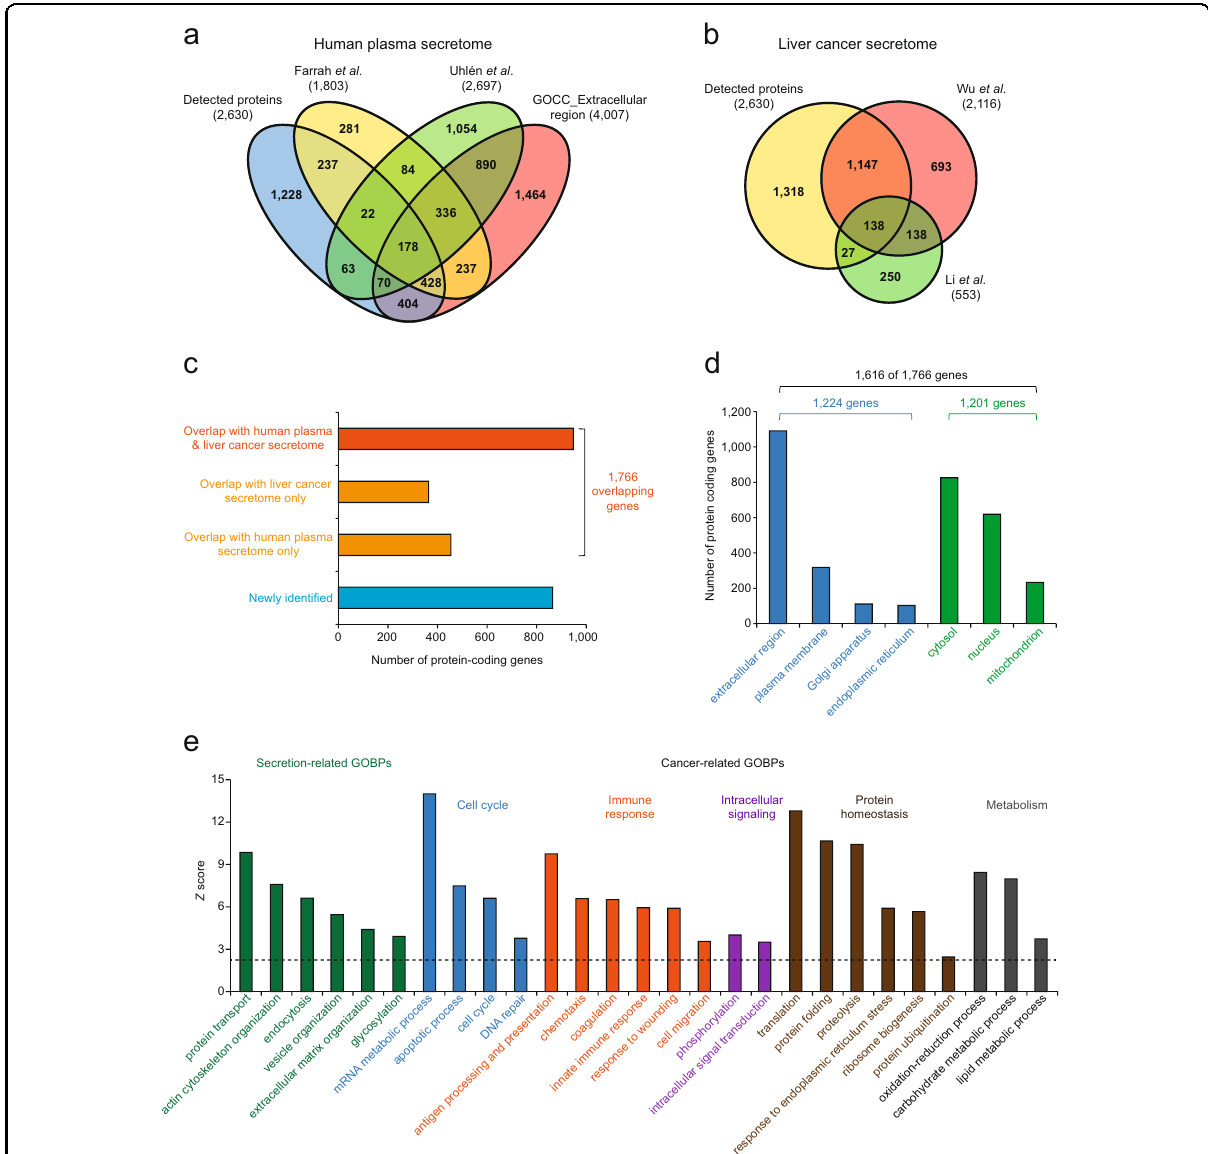
Fig. 2 Comparison of our secretome with the previous secretomes and localization and functional analysis of the secretome. a Comparison of our secretome with human plasma secretomes previously reported and with protein-coding genes known to be localized in the extracellular region based on their GOCCs. b Comparison of our secretome with two previously reported liver cancer secretomes. c 1766 secreted proteins overlapped with human plasma or liver cancer secretomes. d Distribution of cellular localizations (GOCCs) of the overlapping secreted proteins. Bar colors represent the numbers of secreted proteins localized in the compartments related (blue) or unrelated (green) to secretion. e Cellular processes (GOBPs) represented by the 1766 overlapping secreted proteins. Bar colors indicate a group of the process related to secretion (green) and fi ve groups of the processes related to cancer pathophysiology (blue for cell cycle, orange for immune response, purple for intracellular signaling, brown for protein homeostasis, and gray for metabolism). The dashed line denotes the cutoff of P =